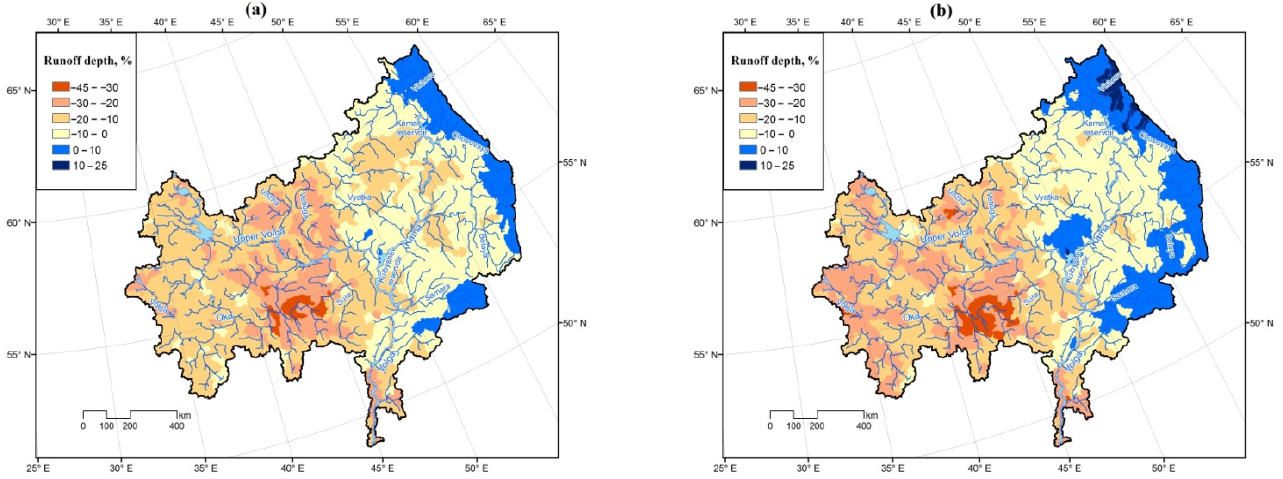
Figure 12. Anomalies of the annual runoff depth in the Volga basin under global warming by 1.5 °C ( a ) and 2 °C ( b ) in the 21st century relative to the average values of the baseline period 1970–1999.